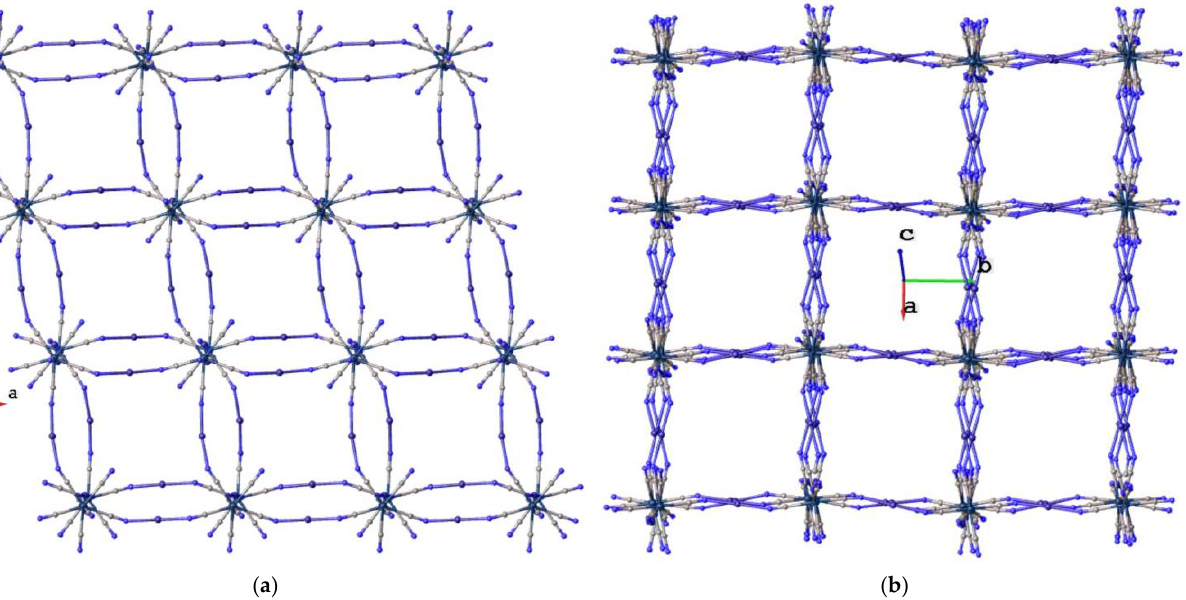
Figure 5. Schematic presentation of the 3D network with distorted cubic topology in 11 (along the 100 direction). Reproduced with permission from ref. [44]. © 2022 American Chemical Society.